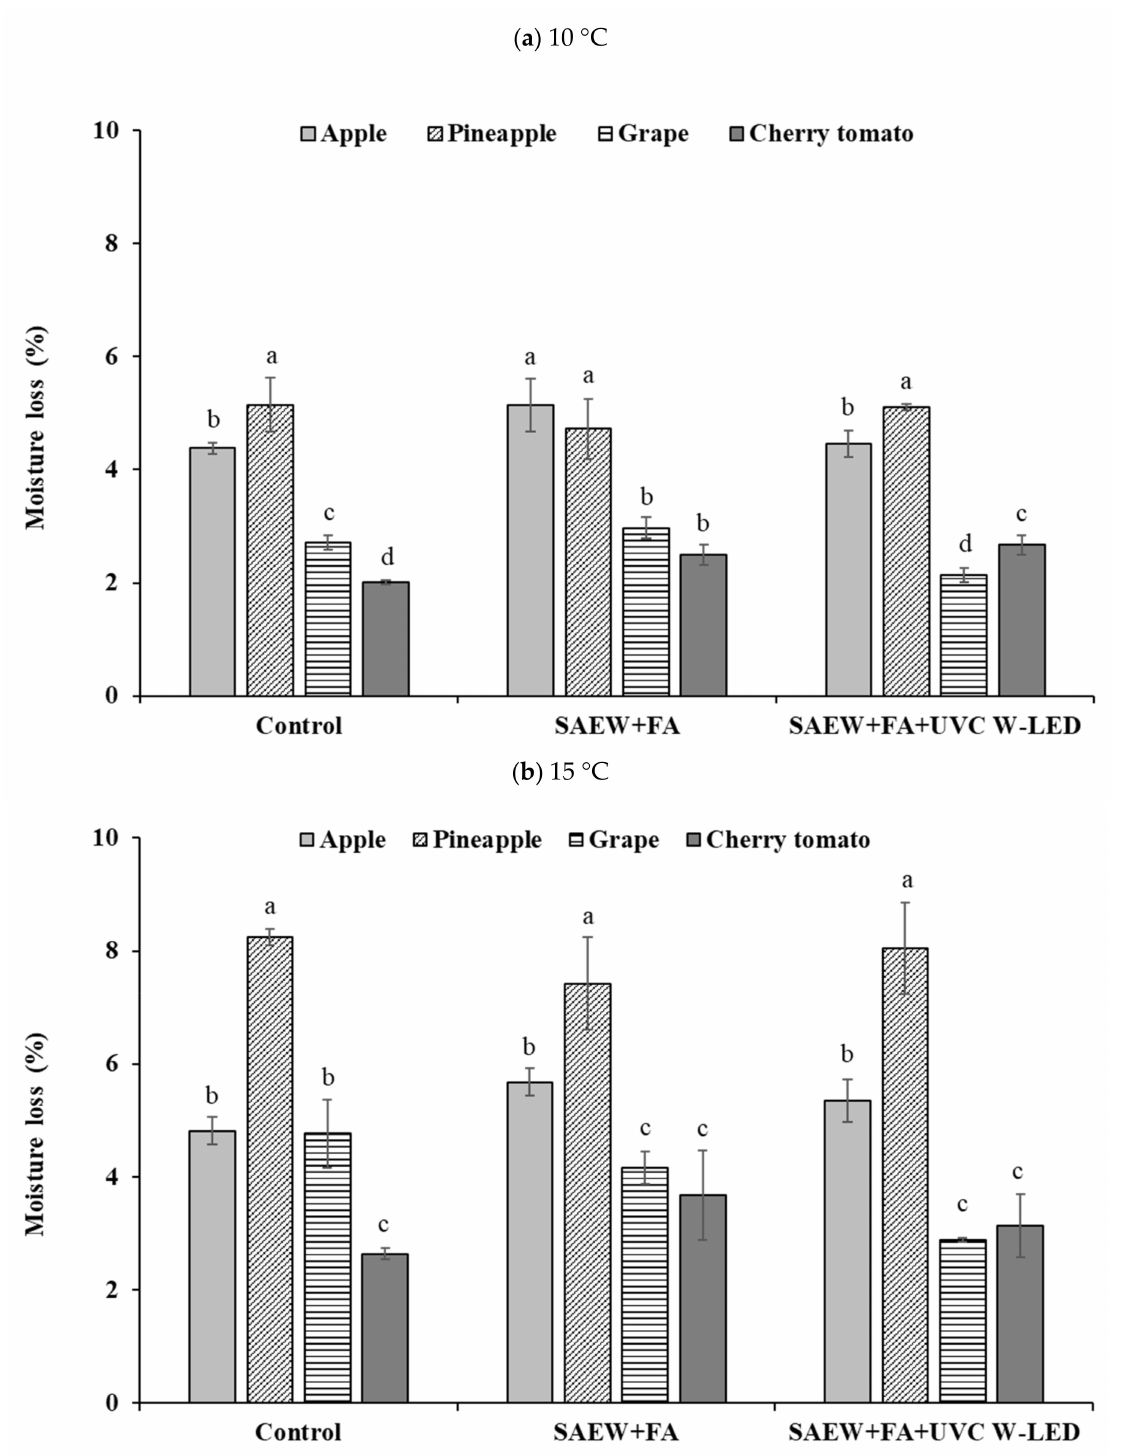
Figure 6. Effectiveness of disinfection treatments on the moisture loss in various fresh-cut fruits stored after 7 days at ( a ) 10 ◦ C and ( b ) 15 ◦ C. Control, no extra wash with a sanitizer; SAEW, slightly acidic electrolyzed water; FA, fumaric acid; UVC W- LED, ultravioletC waterproof light-emitting diodes. a–d values within each treatment represent different by Duncan’s multiple range test at p <